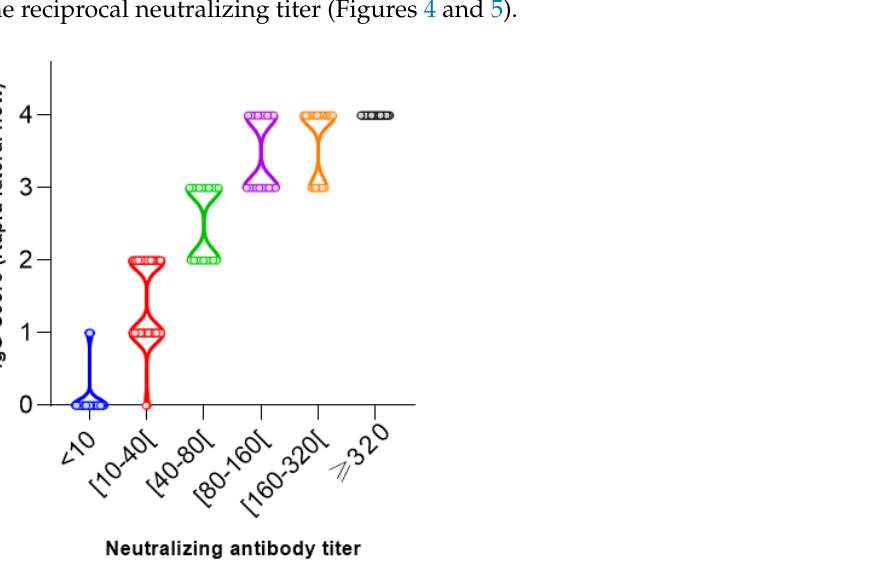
Figure 5. SARS-CoV-2 neutralizing antibody titers correlate with SARS-CoV-2 IgG (VIDAS ® ) (Spearman correlation coefficients ρ = 0.8995 and p -value < 0.0001). The two-dimensional distribution diagrams (Figures 4 and 5) show a moder- ate-to-high correlation with low dispersions of the antibody values within the SN titers. Additionally, median antibody levels increased with increasing neutralizing activity. Correlation coefficient is employed to describe the strength and direction of the linear association between the neutralizing activity and two SARS-CoV-2 tests. Although both assays showed a positive correlation with neutralizing activity, the strongest (ρ = 0.9341) was found for the rapid lateral flow (AAZ ® ) (Figure 4). The VIDAS SARS-CoV-2 IgG assay (Figure 5) showed a moderate positive correlation (ρ = 0.8995). In participants with a negative virus neutralization test (<10), the antibody levels vary remarkably in the VIDAS SARS-CoV-2 IgG assay (Figure 5). The absence of neu- tralization is accompanied by a low antibody level ranging from an index of 1.01 to 3.75 (data not shown). However, we cannot establish a threshold above which neutralization activity is clearly present, due to the overlap of positive and negative values of serum neutralization.